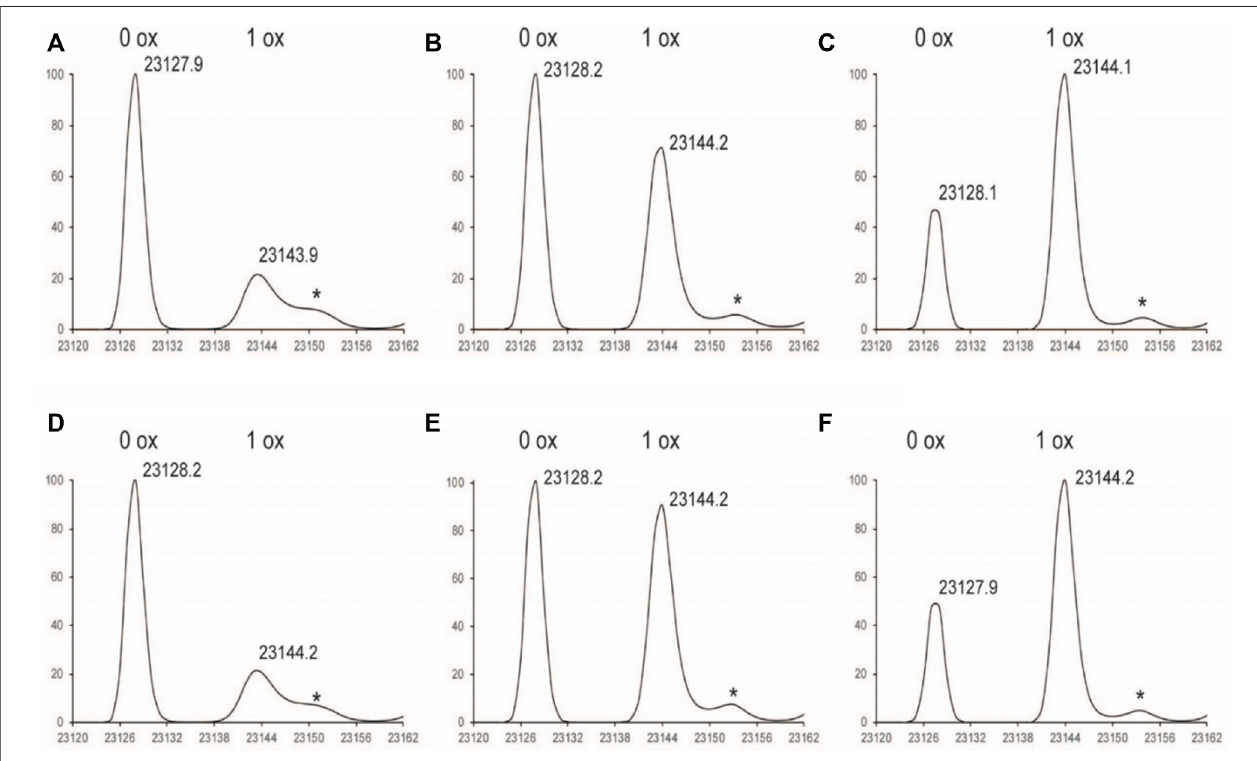
FIGURE 2 | Deconvoluted LC-MS Spectrum of LC subunit (A) 1% Nox 1hr (B) 1% Nox 3hr (C) 1% Nox 6hr (D) 1% PAox 1hr (E) 1% PAox 3hr (F) 1% PAox 6hr *Denotes adduct peaks that do not correspond to actual oxidized antibody peaks.